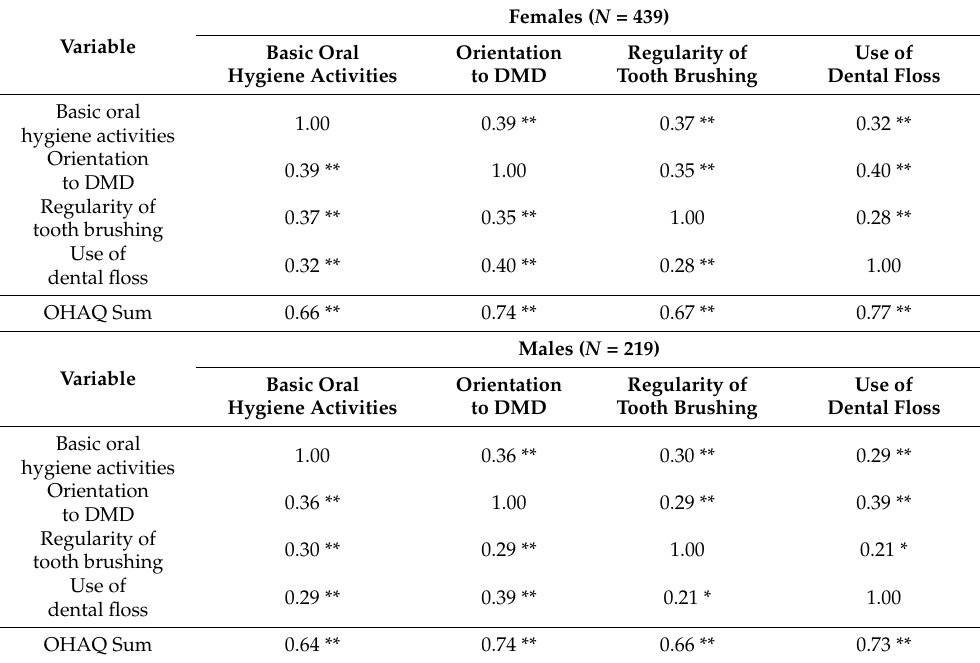
Table 4. Correlations between the OHAQ